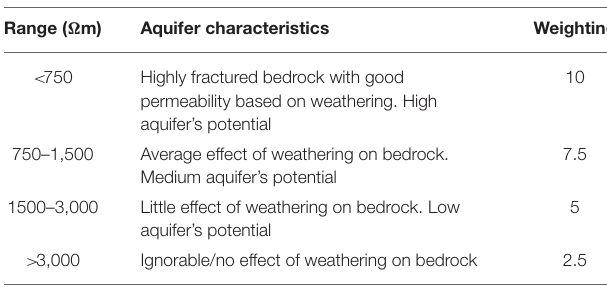
TABLE 4 | Aquifer’s yield due to the contributions of bedrock resistivity [modified with the permission of “RMZ—Materials and Geoenvironment” after ( Sunmonu et al., 2012